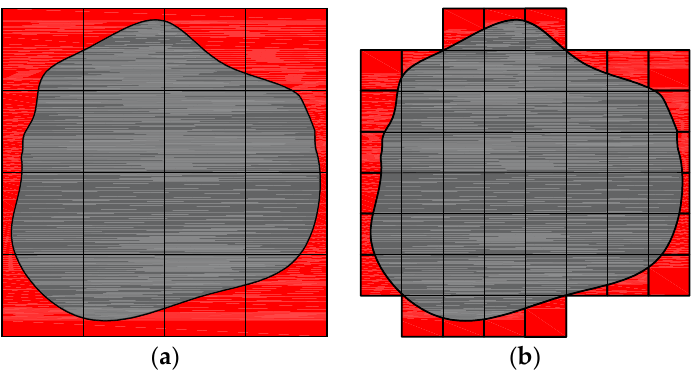
Figure 13. The schematic sketch of the pore covering at different side lengths: ( a ) r > 4.1; ( b ) r < 4.1.